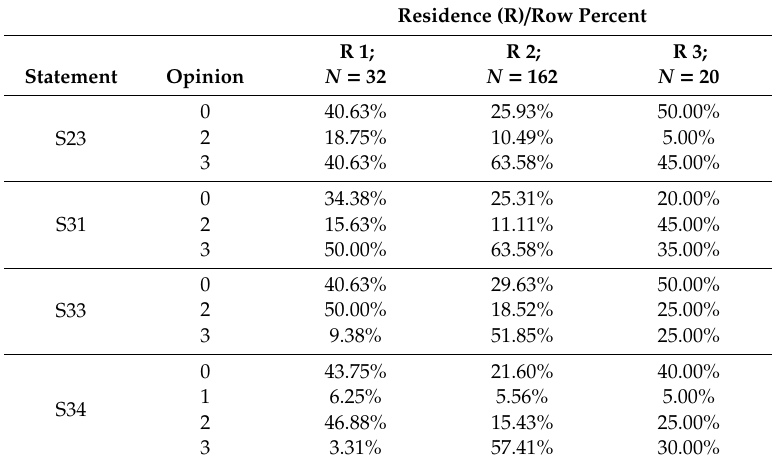
Table 3. Residence as a factor significantly influencing opinions and attitudes to